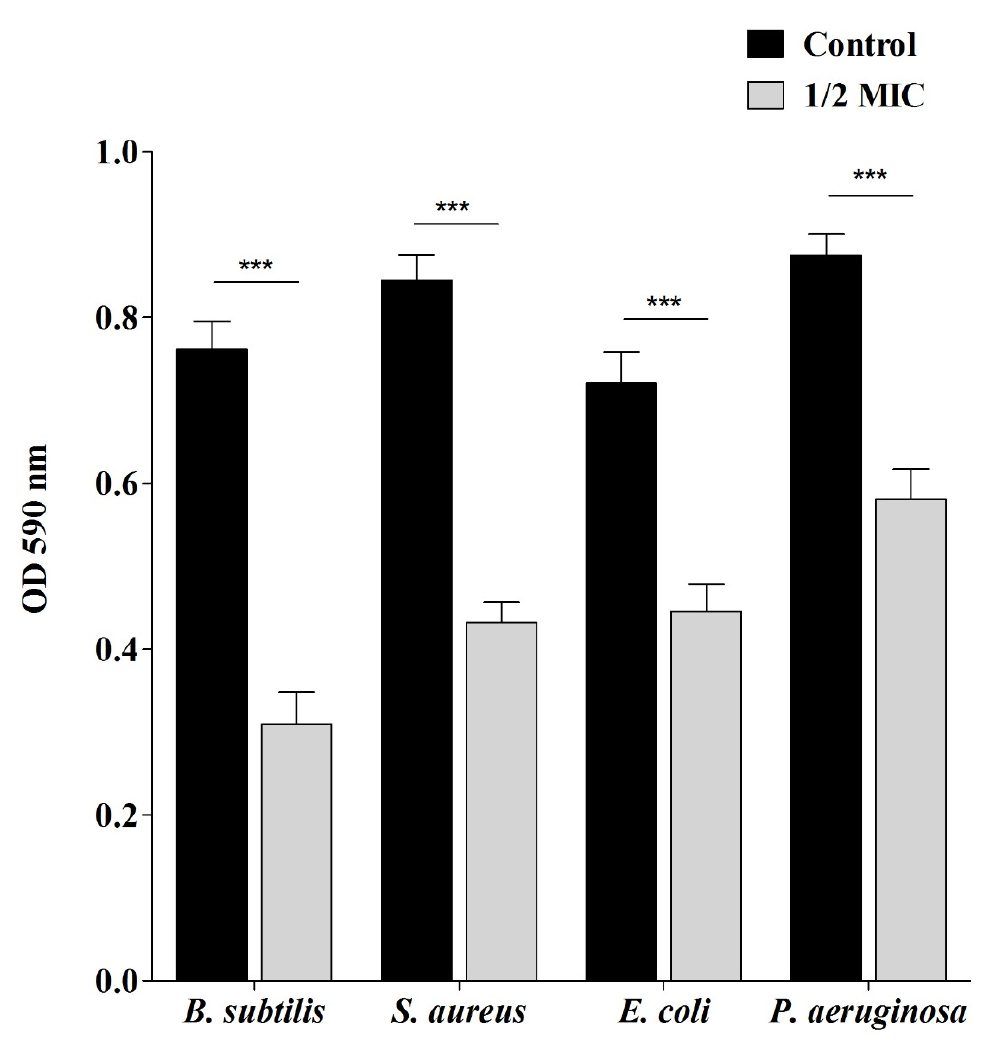
Figure 1. Antibiofilm activity of Sumra honey against four bacterial strains. Sumra honey inhibited the biofilm formation of treated bacteria in comparison with the control, evidenced by reduced optical density. Error bars indicate SDs (±standard deviation) of three independent experiments; Significance; *** p < 0.0001.